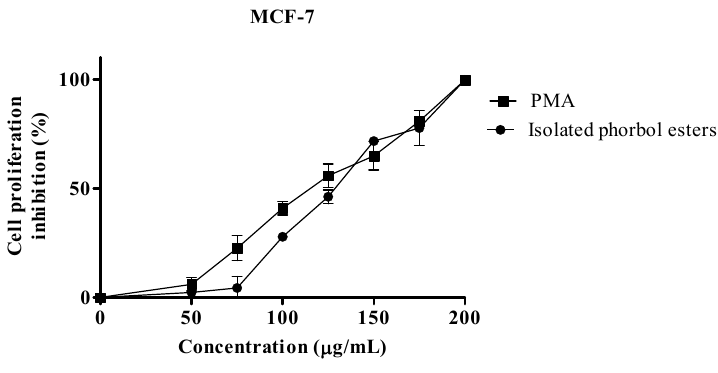
Figure 3. Percentage of cell proliferation inhibition of isolated PEs and PMA on MCF-7 cell line. Values represent mean ± SEM of three replicates.